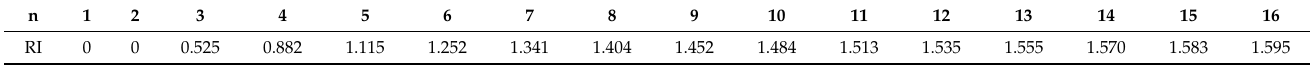
Table 3. Random index (RI) to determine the consistency ratio (CR) of peer comparison matrices